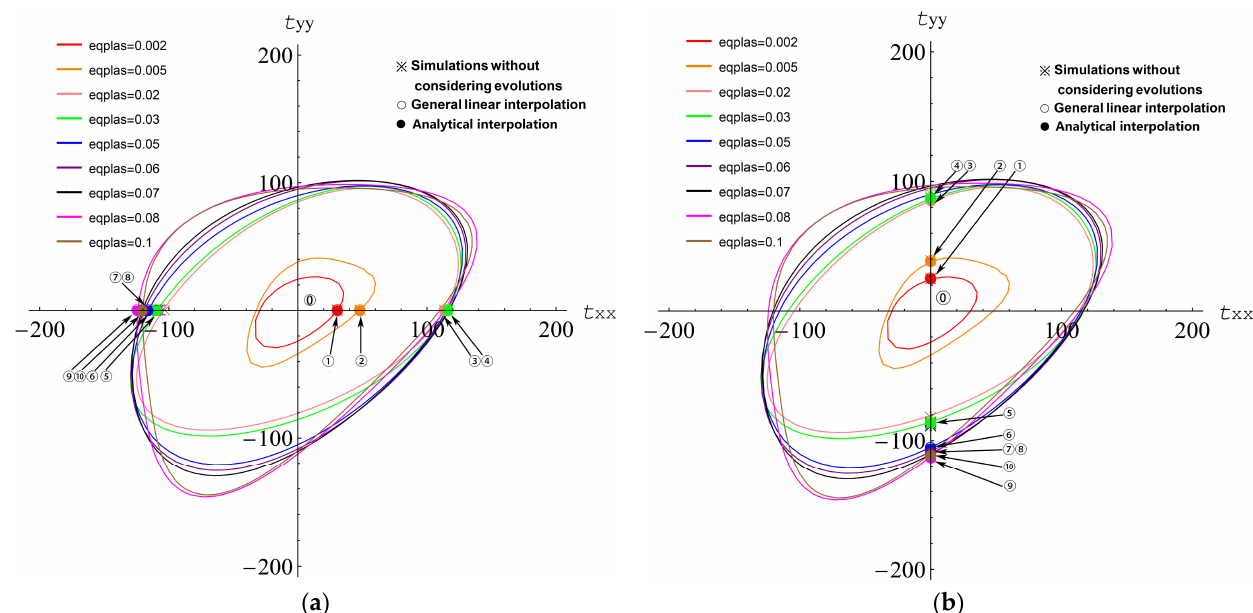
Figure 8. Loading-reverse loading for continuous large deformation loading of ZK60 magnesium alloy: ( a ) X uniaxial tension-X uniaxial compression and ( b ) Y uniaxial tension-Y uniaxial compression.